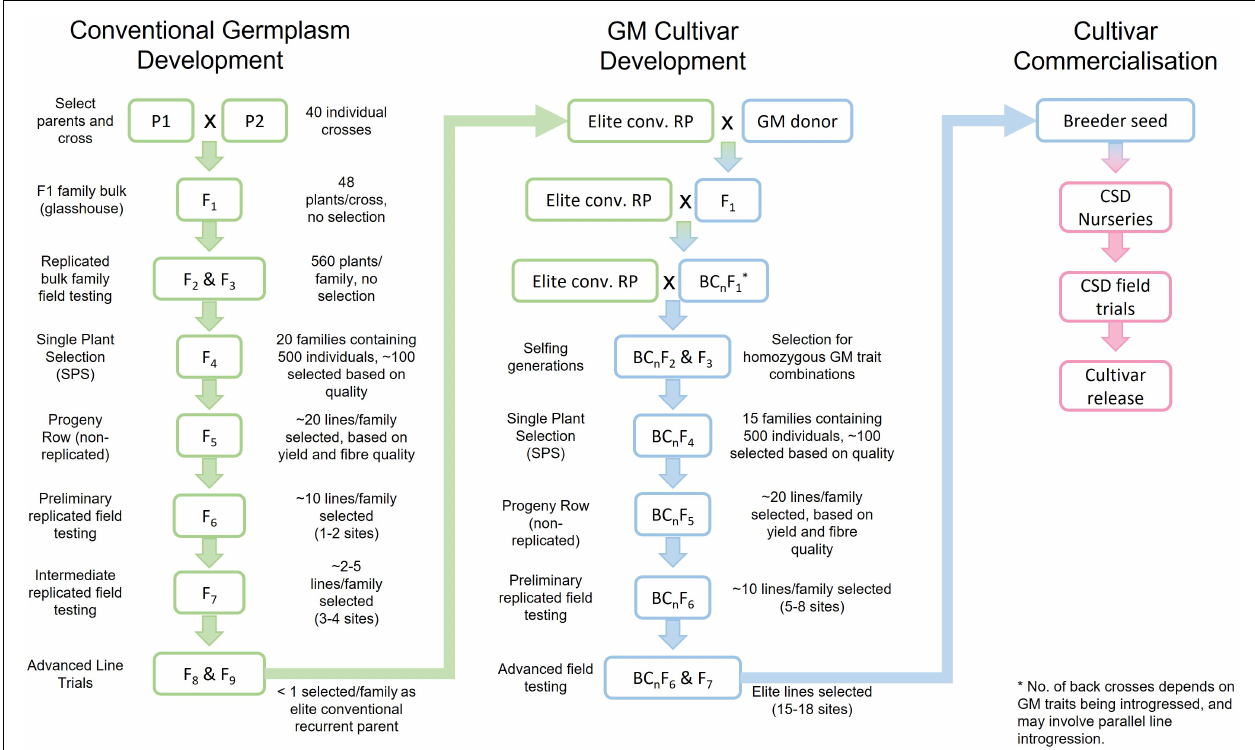
FIGURE 2 | The breeding process used by the Commonwealth Scientific and Industrial Research Organisation (CSIRO) and Cotton Seed Distributors Ltd. (CSD) to develop conventional germplasm and introgress required GM traits, leading to cultivar commercialization. This is a simplified exemplar figure but captures the basic steps in the process. P1 and P2, Parent 1 and Parent 2; F, Filial generation; conv., conventional; RP, recurrent parent; GM, genetically modified; BC, back